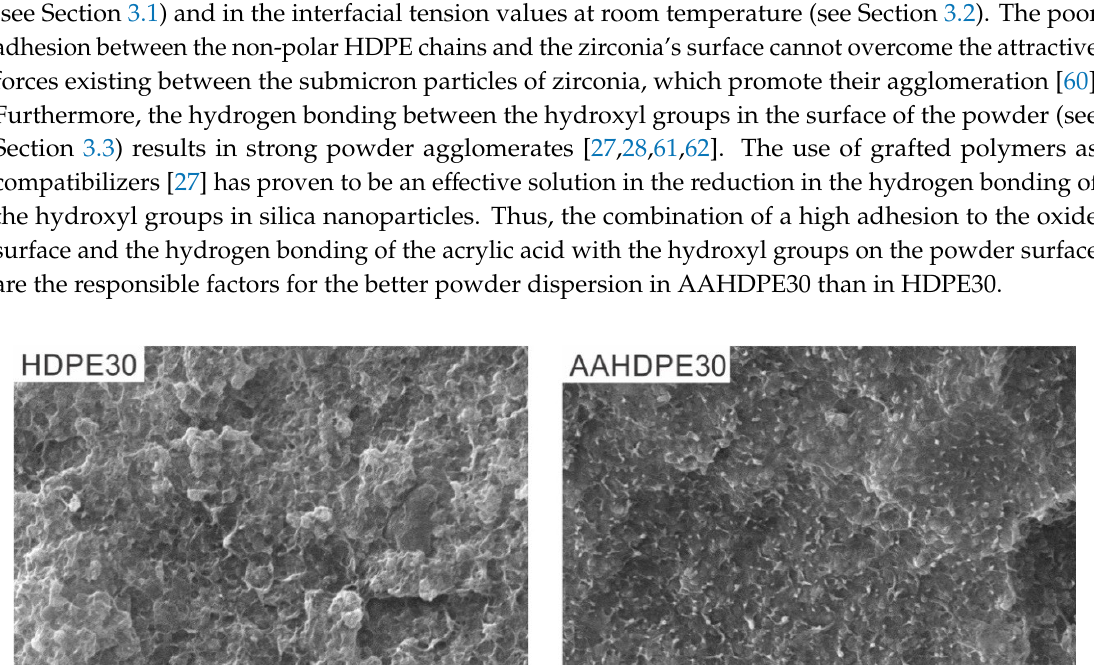
Figure 3. ( a ) Infrared absorption spectrum of the HDPE00, HDPE30, AAHDPE00 and AAHDPE30 with the main peaks of the pure components in different colors; ( b ) Magnification of the infrared absorption spectrum for the AAHDPE00 and AAHDPE30 in the 2000–1500 cm -1 range with the carboxyl peak for the polymer and the composite.